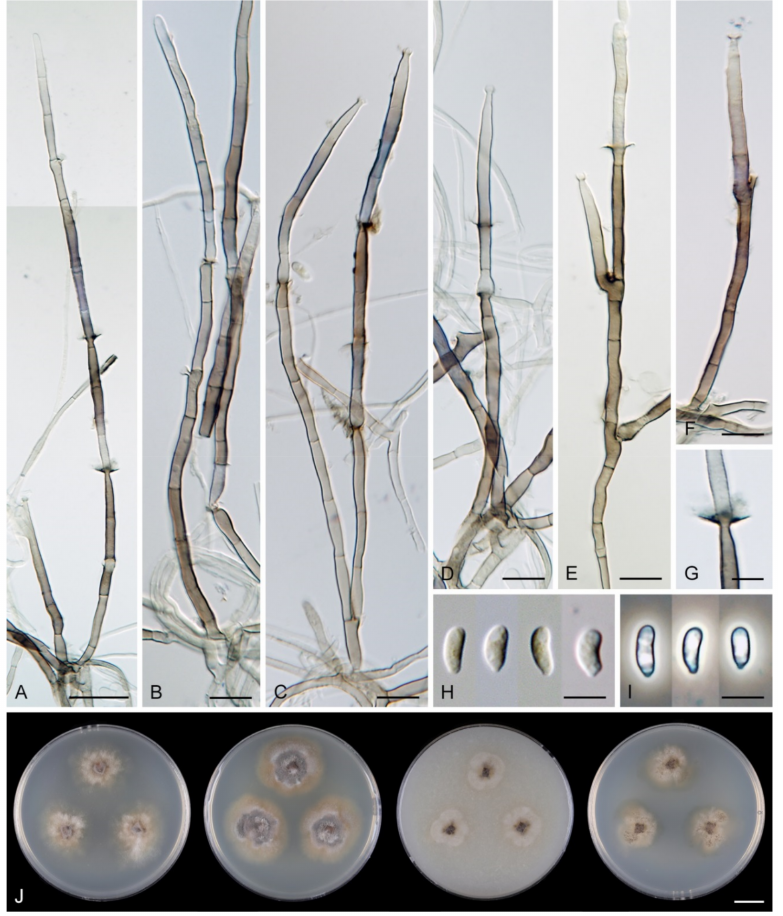
Figure 6. Flectospora laminata . (CBS 112964 ex-type). ( A – F ) conidiophores ( G ) saucer-shaped collarette ( H , I ) conidia ( J ) colonies on CMD, MLA, OA and PCA after 4 weeks (from left to right). Images: ( A – I ) on PCA after 4–6 weeks. Scale bars: ( A ) 20 µ m; ( B – F ) 10 µ m; ( G – I ) 5 µ m; ( J ) 1